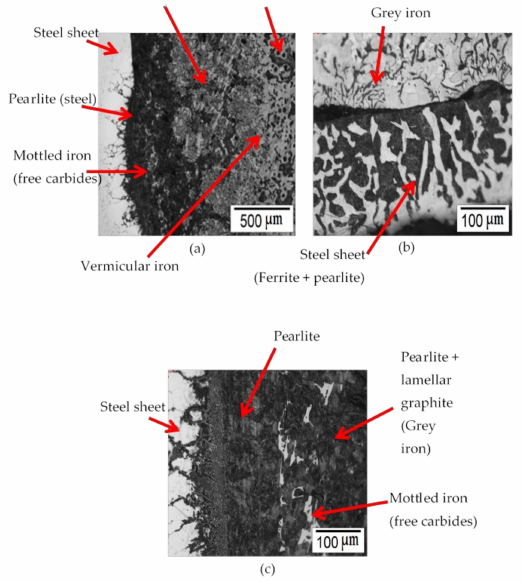
Figure 6. The steel sheets’ effects on the interface liquid ductile iron-furan resin mold: ( a )-mixed structures at the interface (steel-cast iron); ( b )-Widmannstaten structure in the steel sheet; ( c )-mottled cast iron structure in the surface layer (details from photo ( a